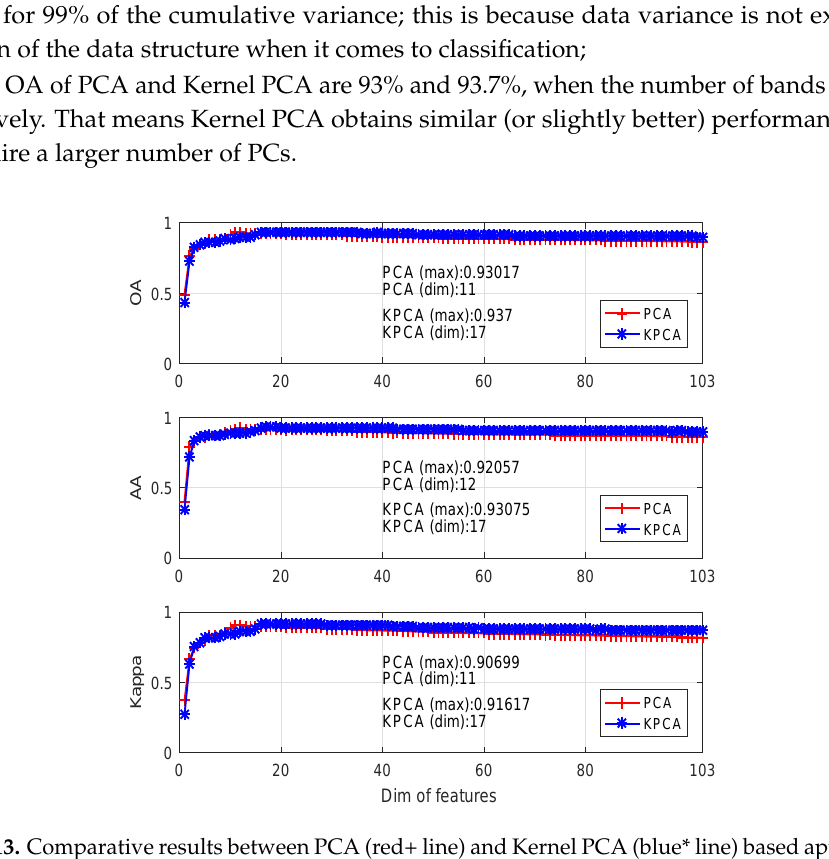
Figure 13. Comparative results between PCA (red+ line) and Kernel PCA (blue* line) based approaches.